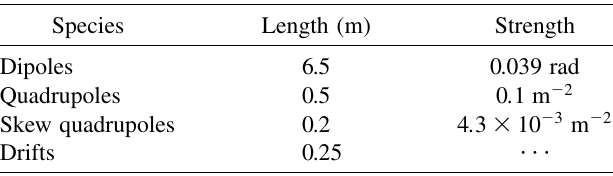
TABLE I. FODO lattice parameters. Species Length (m) Strength Dipoles 6.5 0.039